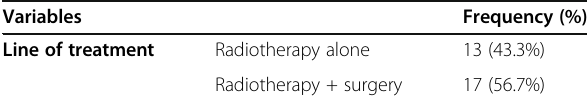
Table 1 Lines of treatment